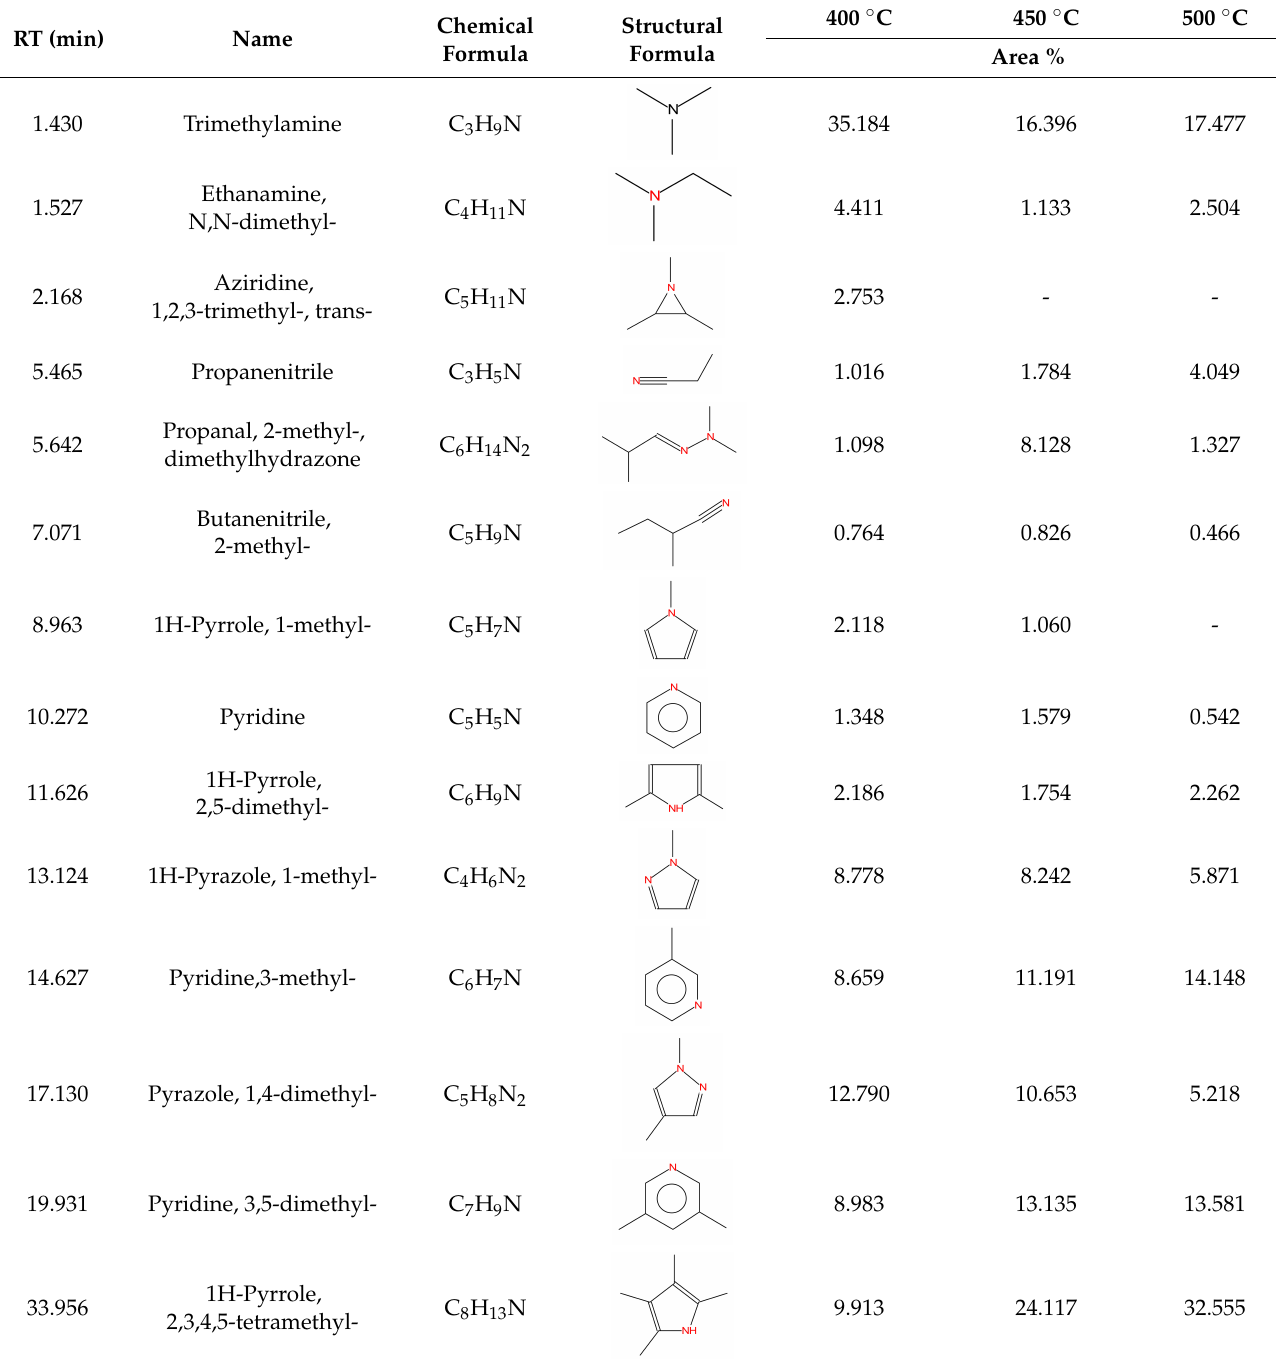
Table 2. Identities and relative amounts of compounds in residual